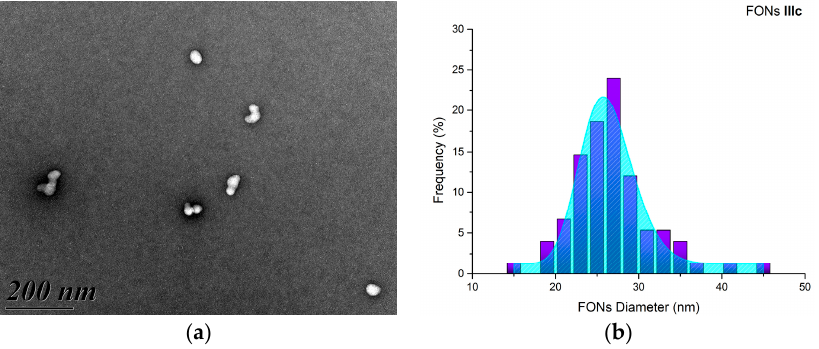
Figure 3. ( a ) TEM image of FONs IIIc ; ( b ) Size distribution and Log Normal fitting of FONs IIIc . Table 3. Structural characterization of FONs made from push-pull derivatives I – IIIa – c .